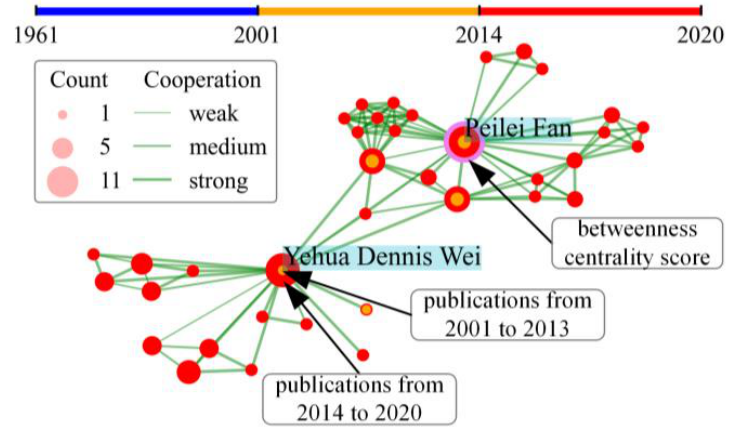
Figure A2. An example of co-authorship analysis results. The burst detection algorithm proposed by Kleinberg [115] can detect significant changes in the frequency of keywords or terms over a short period of time. A detected burst term has two features: burst strength and burst duration. High burst